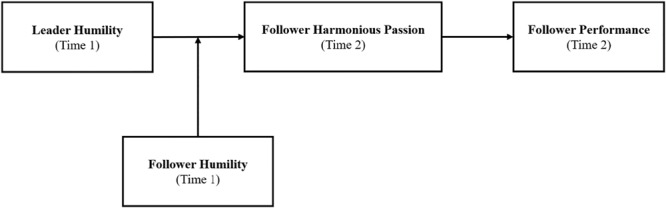
Theoretical model.